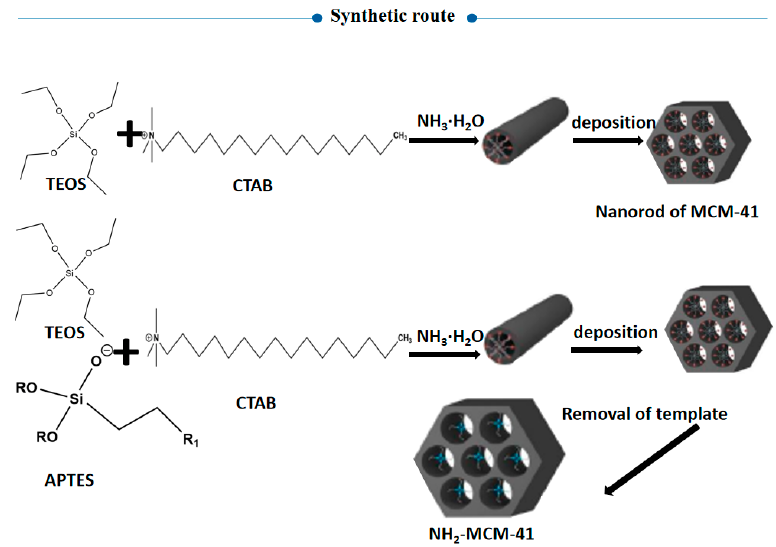
Figure 3. Synthesis route of aminated mesoporous silicon.